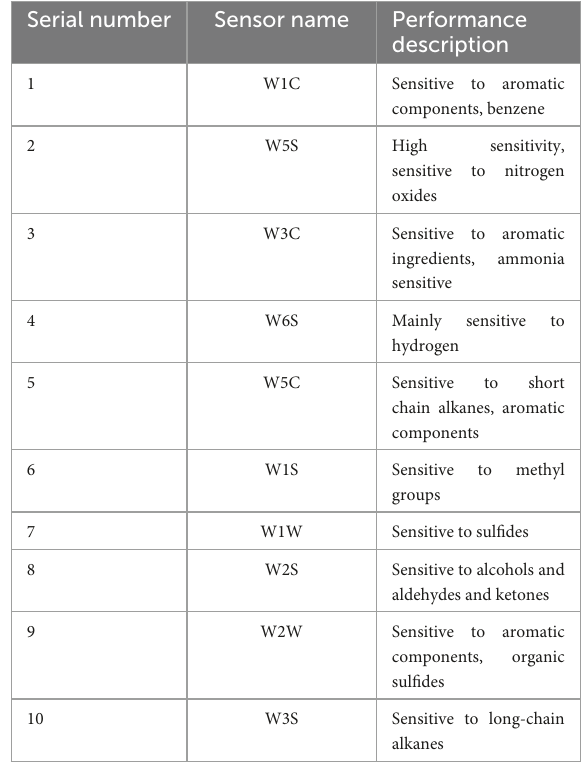
TABLE 2 Sensitive substances of PEN3 electronic nose